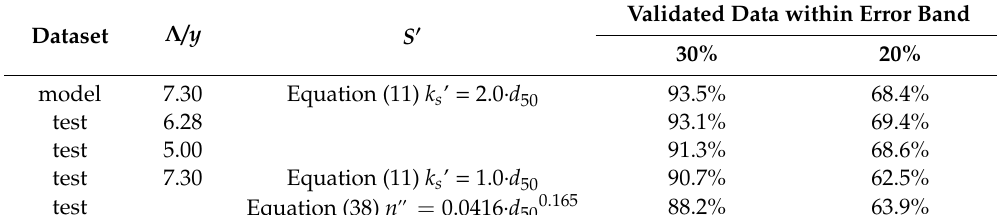
Table 3. Sensitivity analysis of the bed surface roughness and the dune geometry predictor.